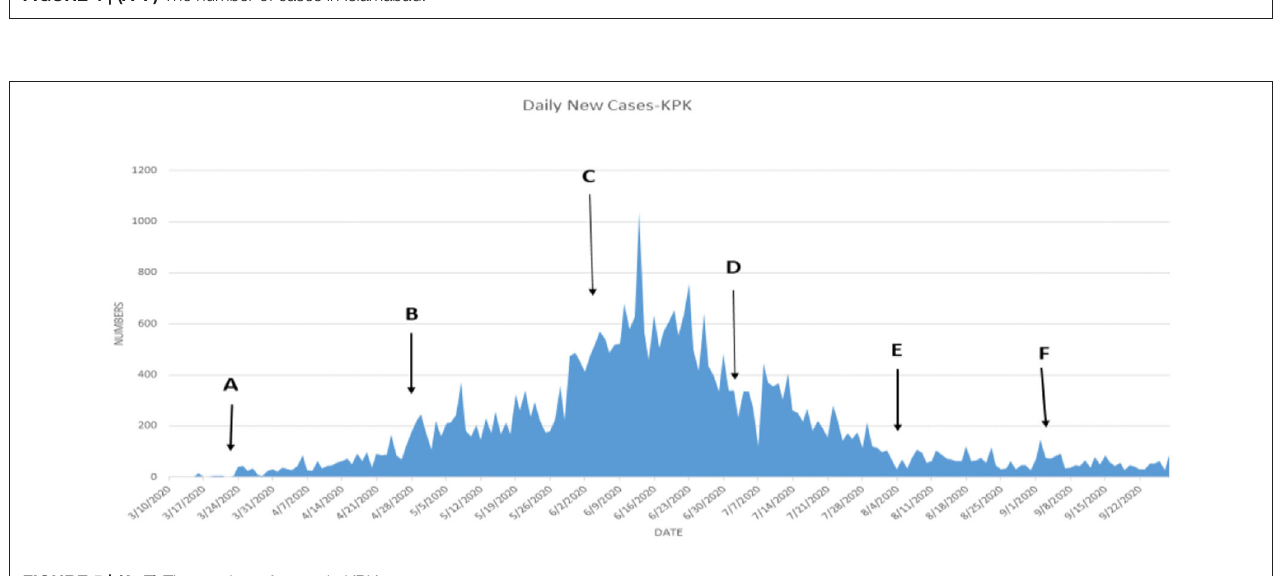
FIGURE 4 | (A–F) The number of cases in Islamabad.